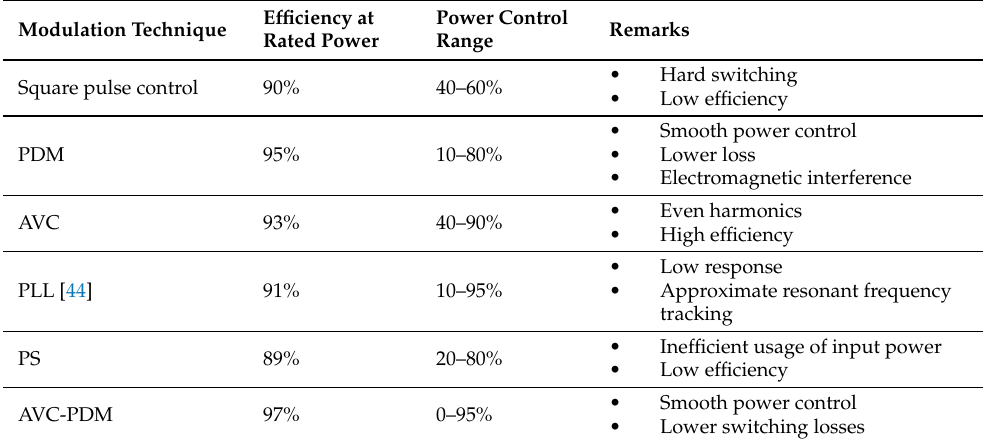
Table 5. Comparative study on different modulation